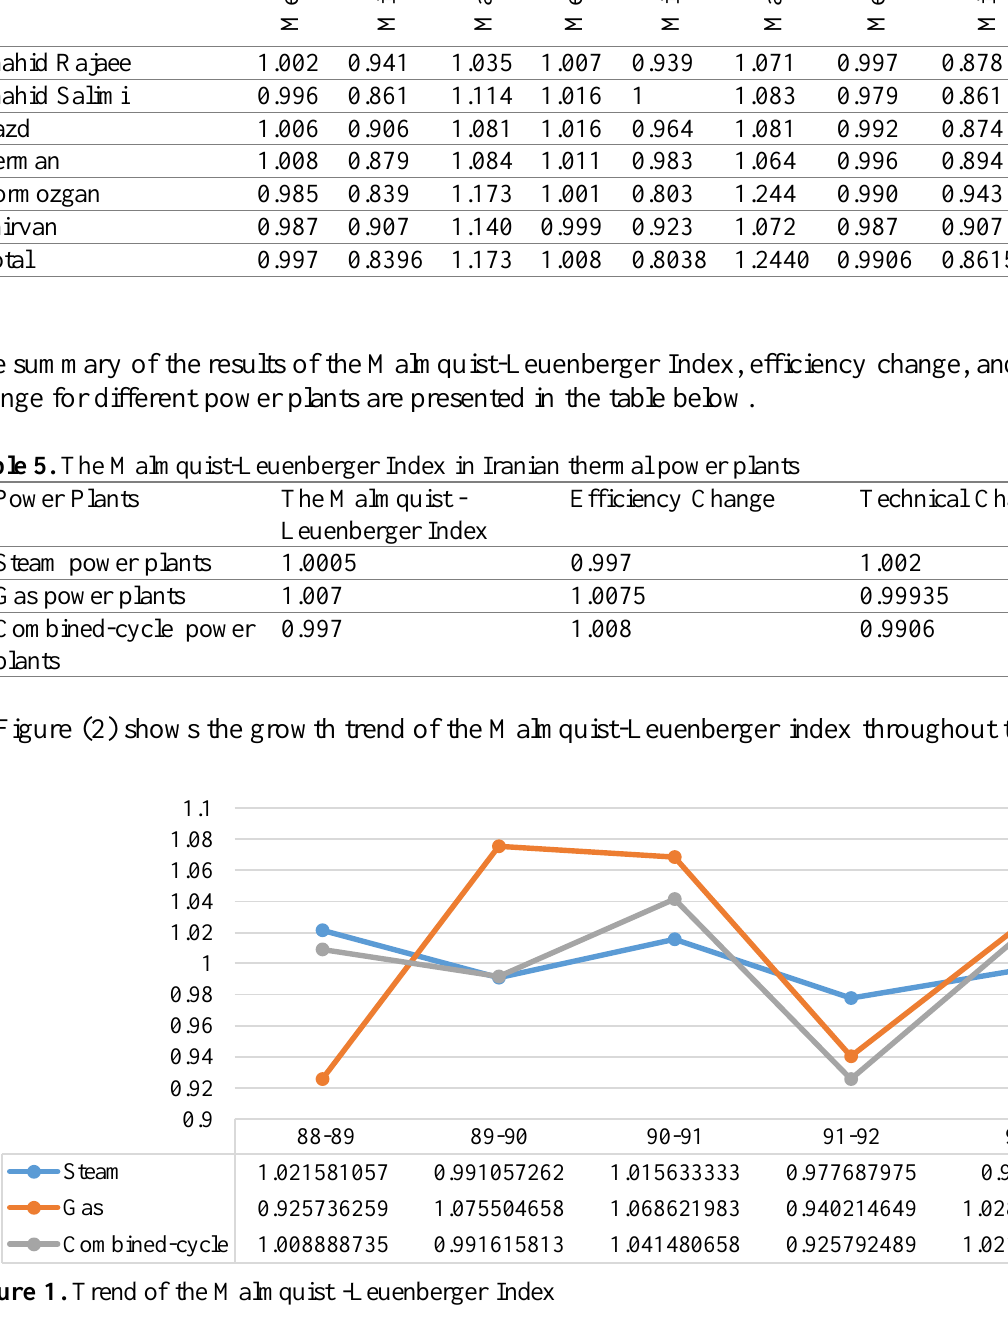
The Malmquist - Leuenberger Index